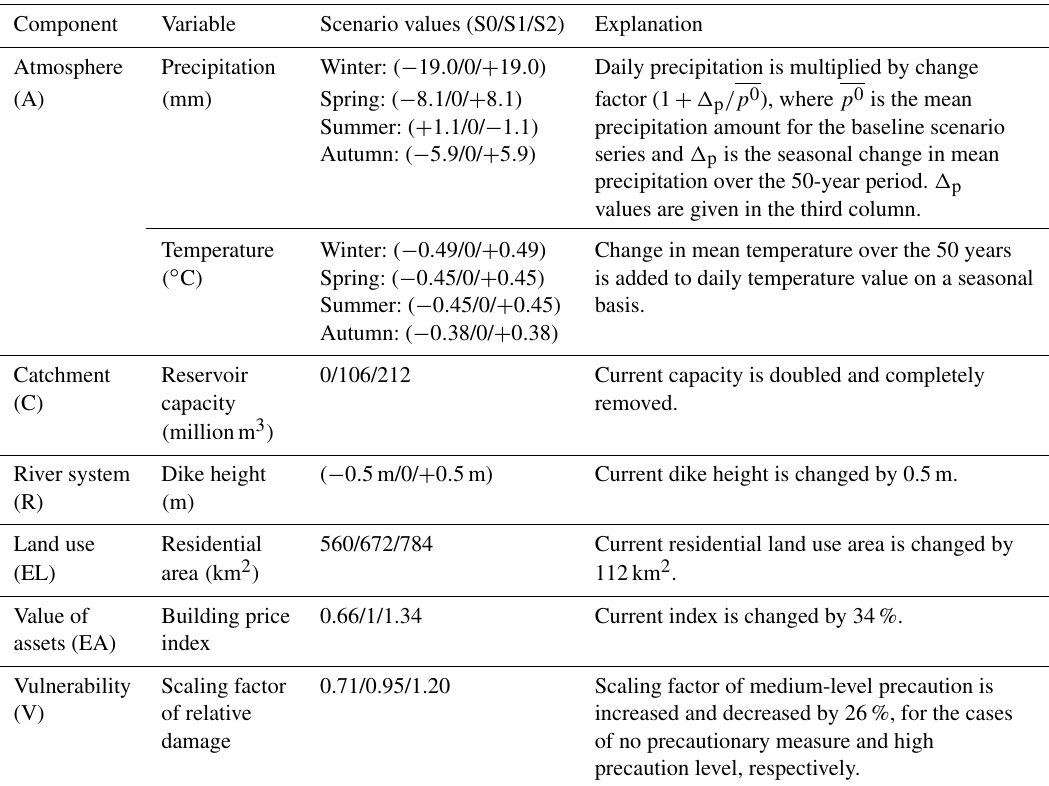
Table 2. Baseline and change scenarios for the sensitivity analysis. For each component the variables that are changed in the sensitivity analysis and their scenario values (S1: baseline; S0, S2: change scenarios) are given.